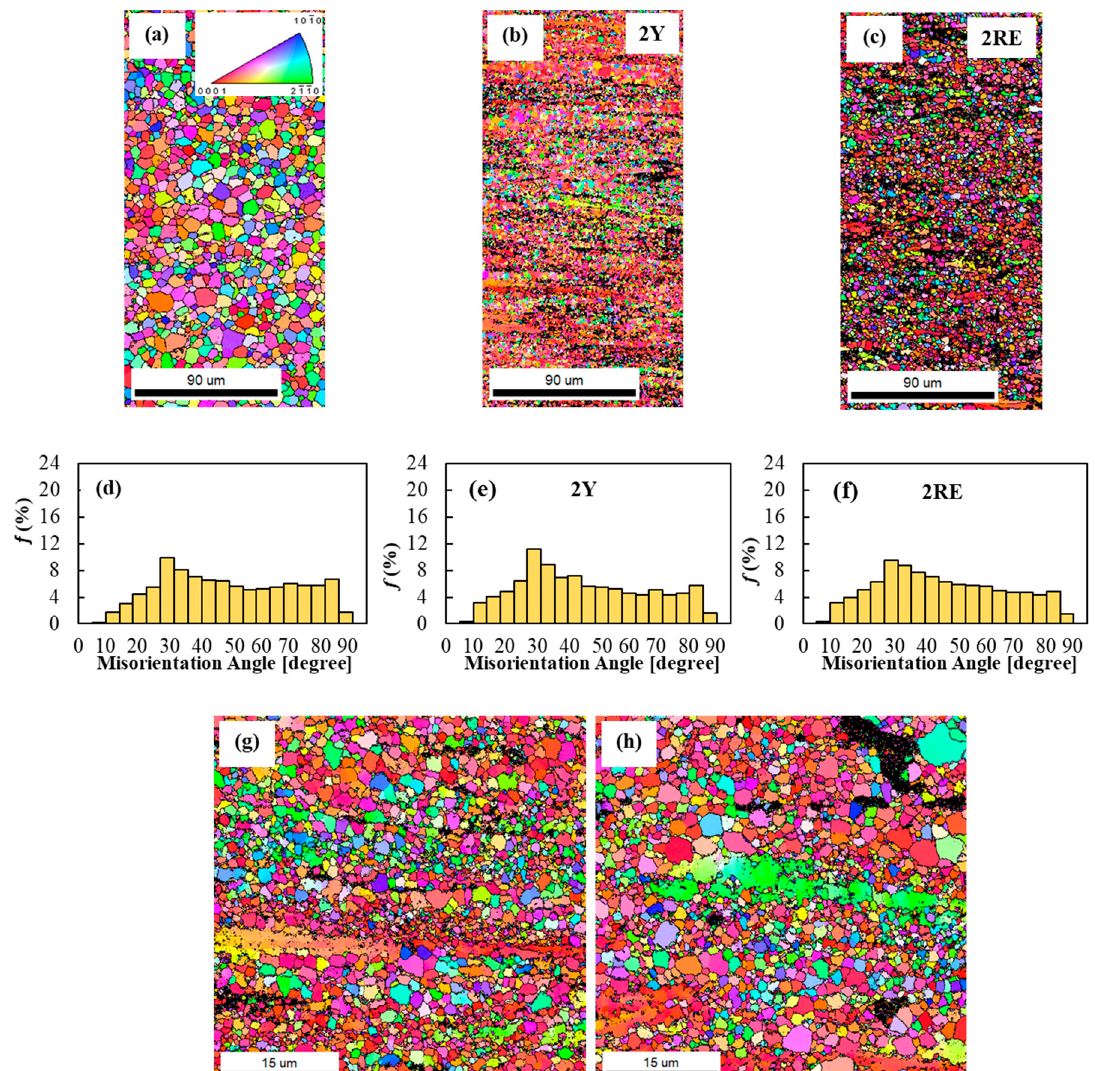
Figure 4. ( a – c ) EBSD grain orientation maps (the extrusion direction is horizontal), and ( d – f ) misorientation angle distribution histograms for ZK60, ZK60–2Y, and ZK60–2RE alloys, and higher magni fi cation EBSD maps for ( g ) ZK60–2Y, and ( h ) ZK60–2RE alloys.